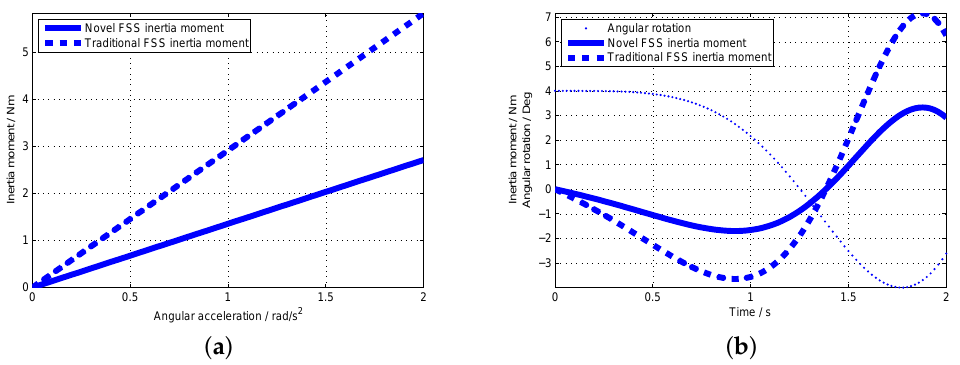
Figure 10. Inertia moment comparison of novel and traditional FSS. ( a ) Inertia moment under different angular acceleration; ( b ) Inertia moment changed with motion.